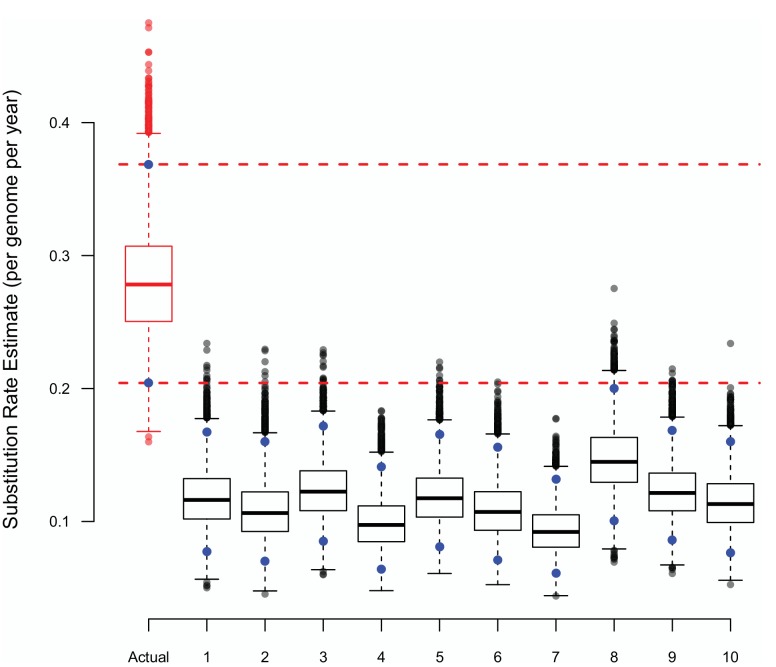
The substitution rate estimates from BASTA using either true or randomly shuffled sampling dates.The upper (97.5%) and lower (2.5%) bounds of each distribution are shown as blue points, the horizontal dashed lines represent the same bounds for the estimates based on the actual dates. Each BASTA analysis using a two population (badgers and cattle) structure, allowed different but constant population sizes, and relaxed clock model based upon an HKY substitution model.